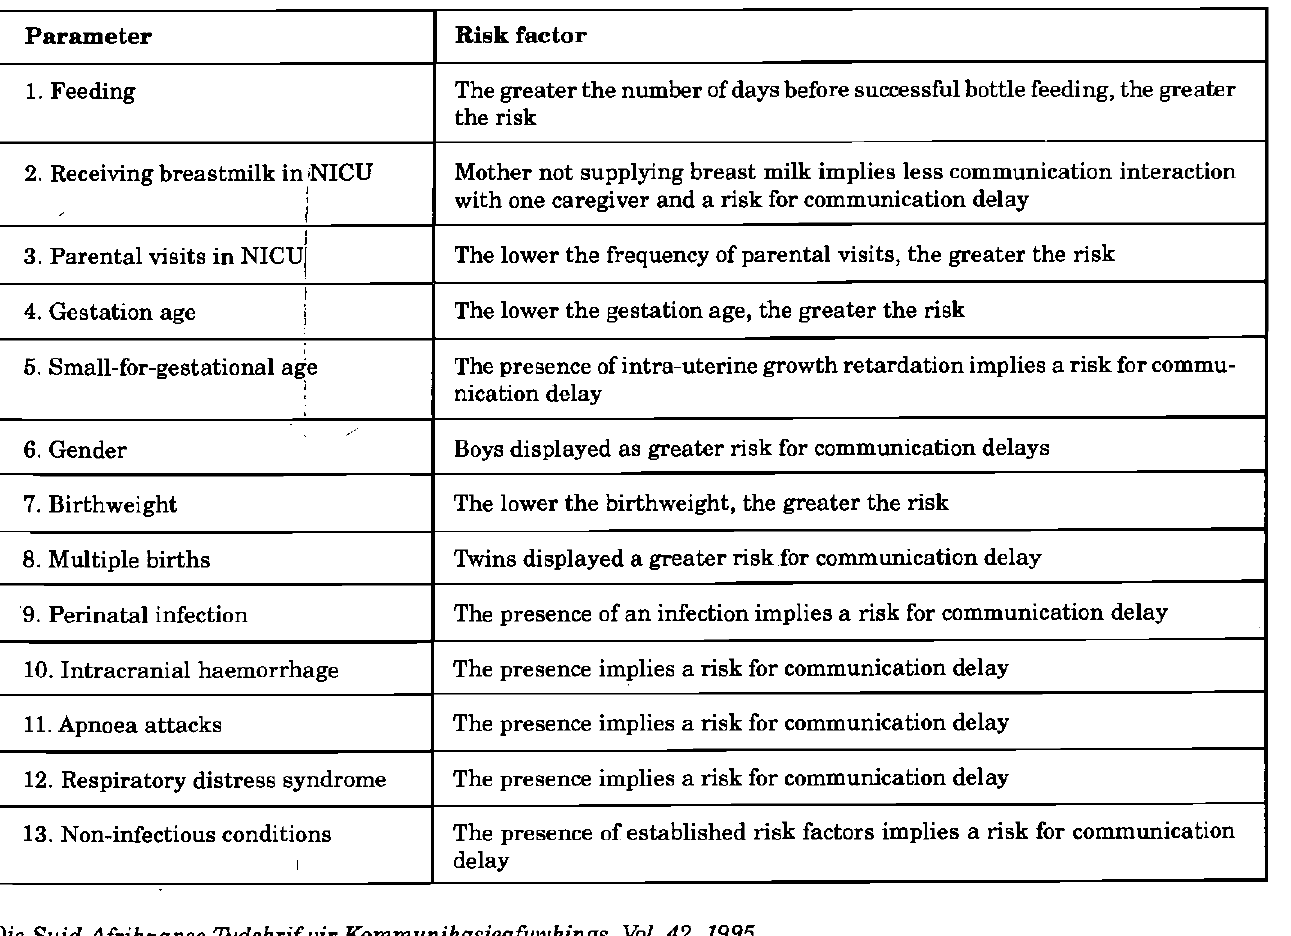
Table 4: High risk register for the prediction of the subjects' communication development, N=50